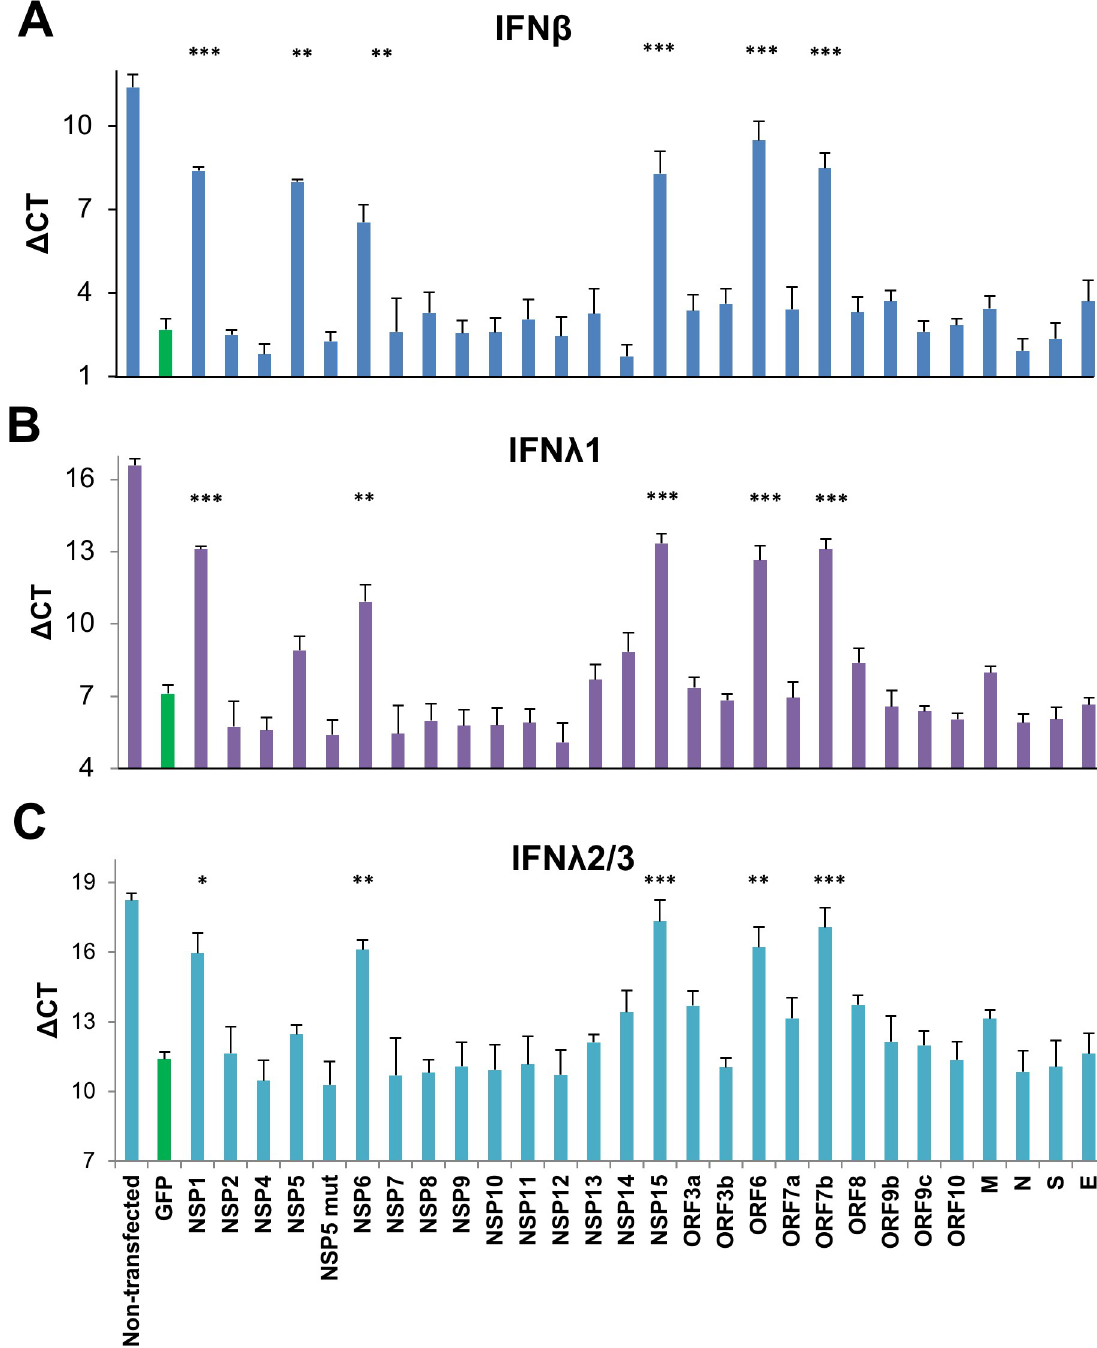
Fig 4. Suppression of MAVS induced IFN β , IFN λ 1 and IFN λ 2/3 gene expression by SARS-CoV-2 genes determined by qPCR. HEK- 293T cells were transfected with MAVS and a SARS-CoV-2 viral gene or GFP. 24 hours post transfection, transcript levels were analyzed by qPCR. The data presented are expression levels normalized to housekeeping gene HPRT1 ( Δ CT). Results are shown for (A) IFN β ; (B) IFN λ 1; and (C) IFN λ 2/3 (common primers amplify both IFN λ 2 and IFN λ 3). Data presented are means of 2–4 independent experiments ± SEM. Significance was compared to the GFP positive control: � P < 0.05, �� P < 0.001, ��� P < 0.0001.